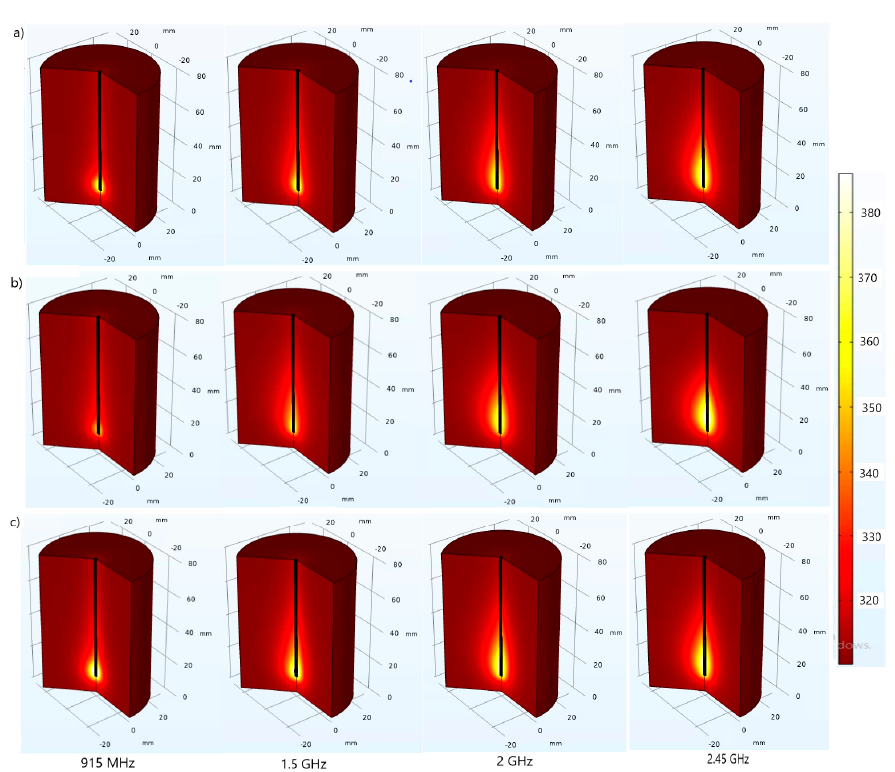
Figure 4. The 3D plot of the temperature (expressed in Kelvin) distributions obtained with the dielectric parameters that characterized ( a ) inflated lungs [52], ( b ) deflated lungs [52], and ( c ) constant values [53,54] at microwave frequencies between 915 MHz and 2.45 GHz.